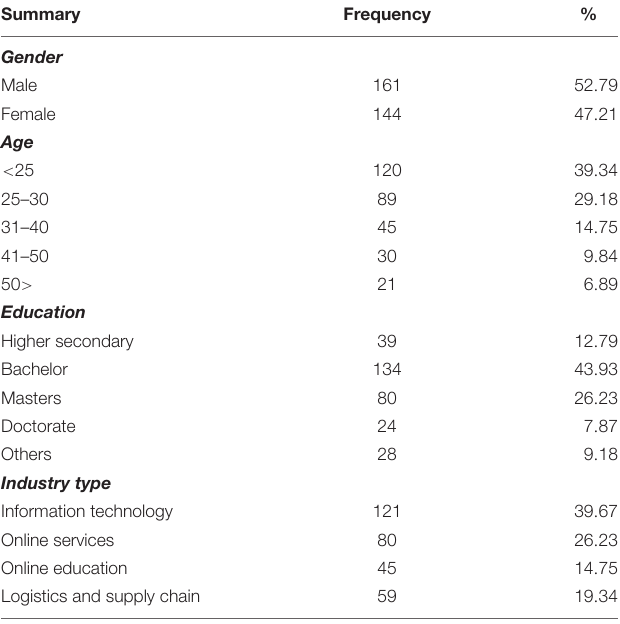
TABLE 1 | Demographic